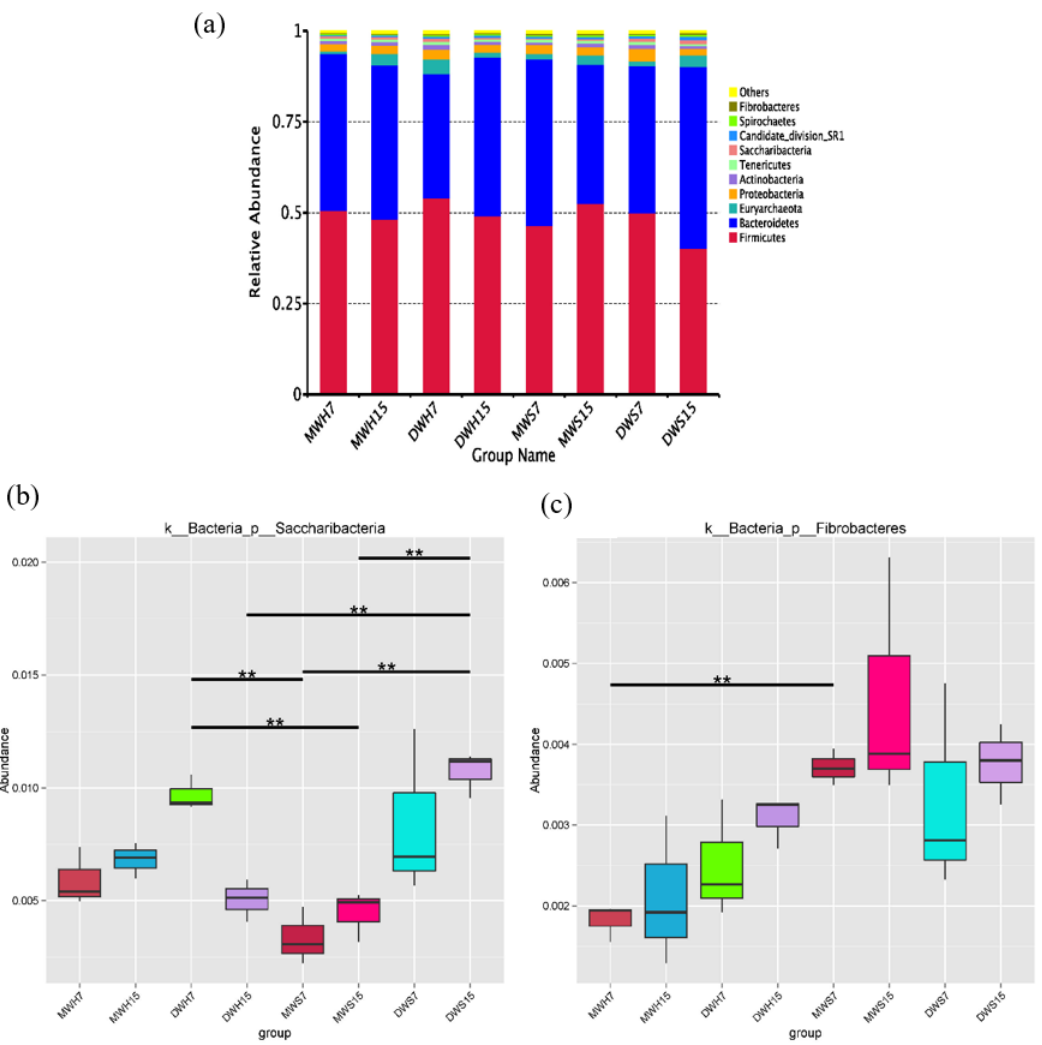
Figure 3. Taxonomic profiles at the phylum level in anaerobic fermentation of different treatments from 16S rRNA gene sequencing. ( a ) The relative abundance of the top 10 phyla of rumen microbial community among treatments; ( b ) The differences of the phylum Saccharibacteria among the treatments; ( c ) The differences of the phylum Fibrobacteres among the treatments. MWH7 = wheat harvested at 7:00 in milk stage and preserved as hay; MWS7 = wheat harvested at 7:00 in milk stage and preserved as silage; DWH7 = wheat harvested at 7:00 in dough stage and preserved as hay; DWS7 = wheat harvested at 7:00 in dough stage and preserved as silage; MWH15 = wheat harvested at 15:00 in milk stage and preserved as hay; MWS15 = wheat harvested at 15:00 in milk stage and preserved as silage; DWH15 = wheat harvested at 15:00 in dough stage and preserved as hay; DWS15 = wheat harvested at 15:00 in dough stage and preserved as silage. ** p < 0.01.